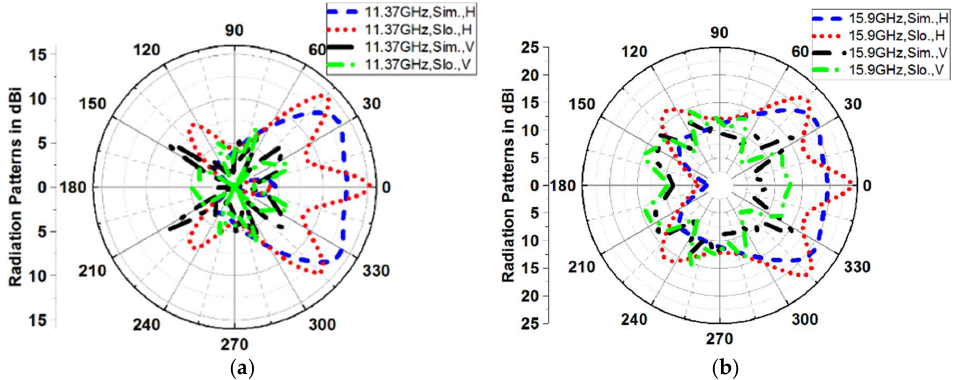
Figure 5. Radiation patterns of the simple reference (sim.) and proposed slotted (slo.) array antennas in the horizontal (H) and vertical (V) planes at ( a ) 11.37 GHz and ( b ) 15.9 GHz. The performance of the proposed technique is compared with other mutual coupling reduction mechanisms in Table 5. Application of decoupling slab between the array elements is a popular conventional technique. Although this results in reducing mutual coupling it does not contribute in reducing the overall size of the array. It is demonstrated here that the proposed technique provides a simple solution of both reducing the surface currents and therefore enhancing the isolation between neighbouring radiators, and overall size reduction, but further work is needed to improve its radiation characteristics. The proposed method offers an average and maximum isolation between transmit and receive antennas of ~15 dB and more than >26 dB, respectively, over a narrow angular range which is better than other techniques. The advantage of the proposed technique is its simplicity. Table 5. Comparison between the proposed array with the recent works. Ref.